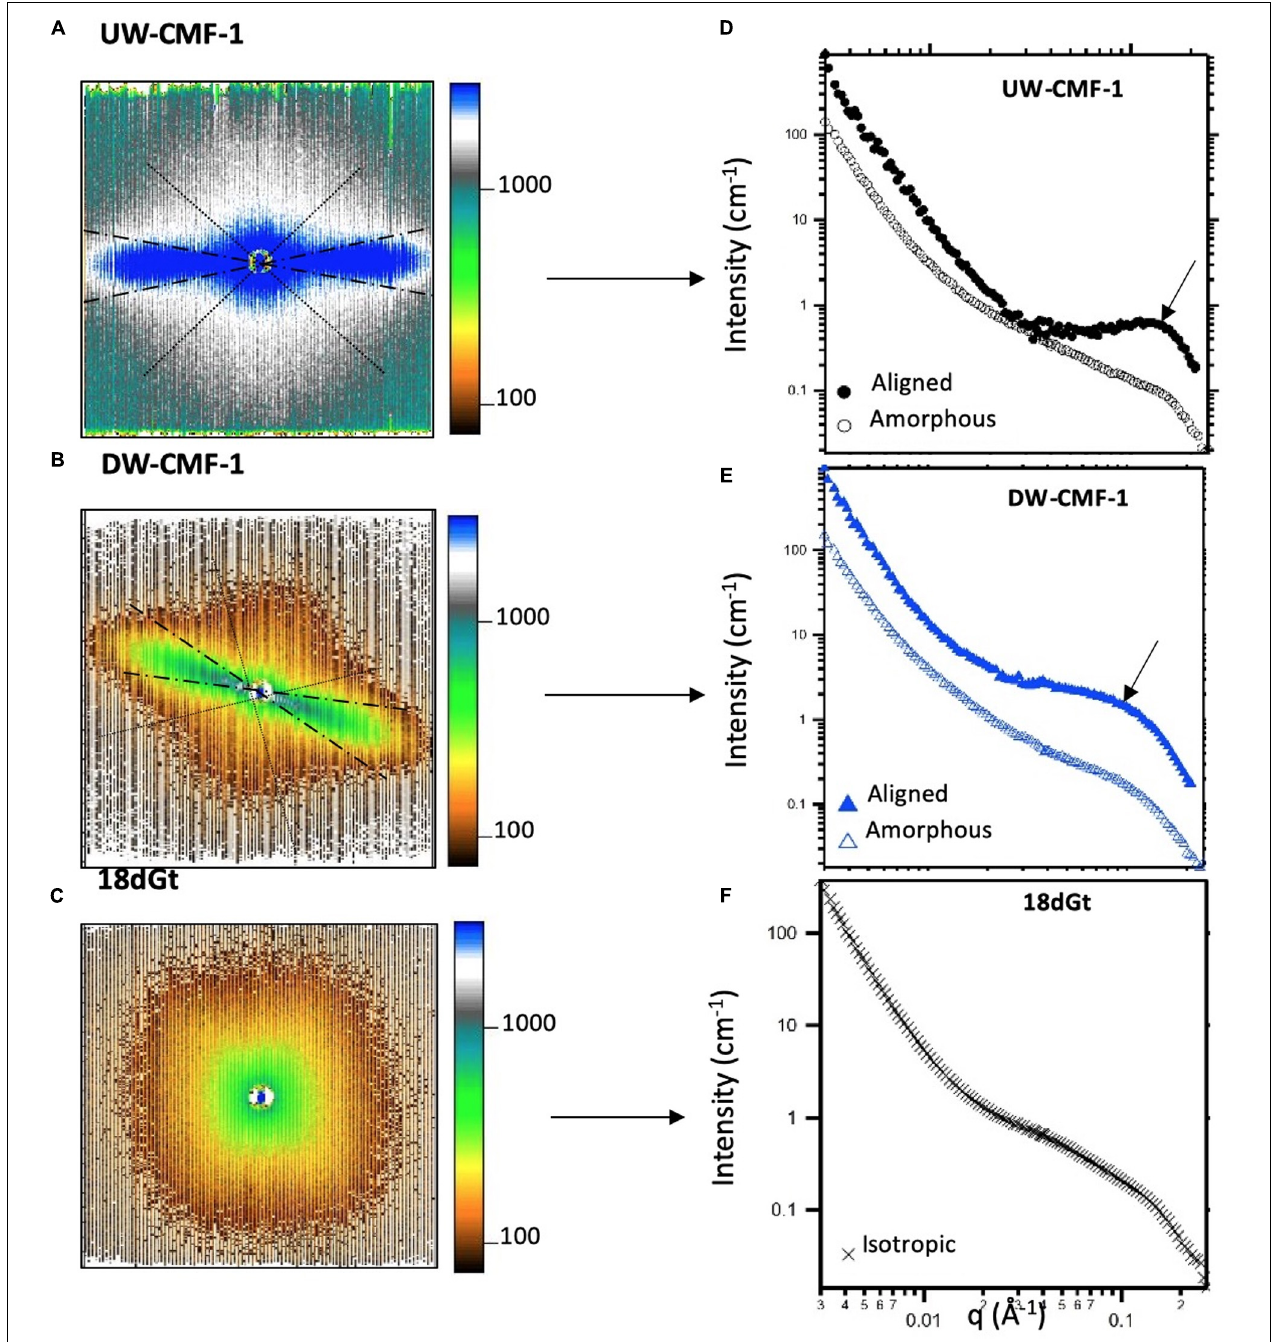
FIGURE 3 | Uncorrected SANS 2D detector images from (A) an unmodified wood disk treated with one pulse of CMF, (B) a delignified wood disk treated with one pulse of CMF, and (C) wood shavings decayed by G. trabeum for 18 days. The aligned sectors used in the data reduction are shown between the dashed radians, and the amorphous sector is enclosed within the dotted lines. All patterns were measured at a sample-to-detector distance of 1.7 m. (D–F) Scattering profiles reduced from the anisotropic and isotropic scattering patterns showing the aligned (closed symbols), amorphous (open symbols) and isotropic curves (crosses). Arrows in d and e show the location where the diffraction peak is